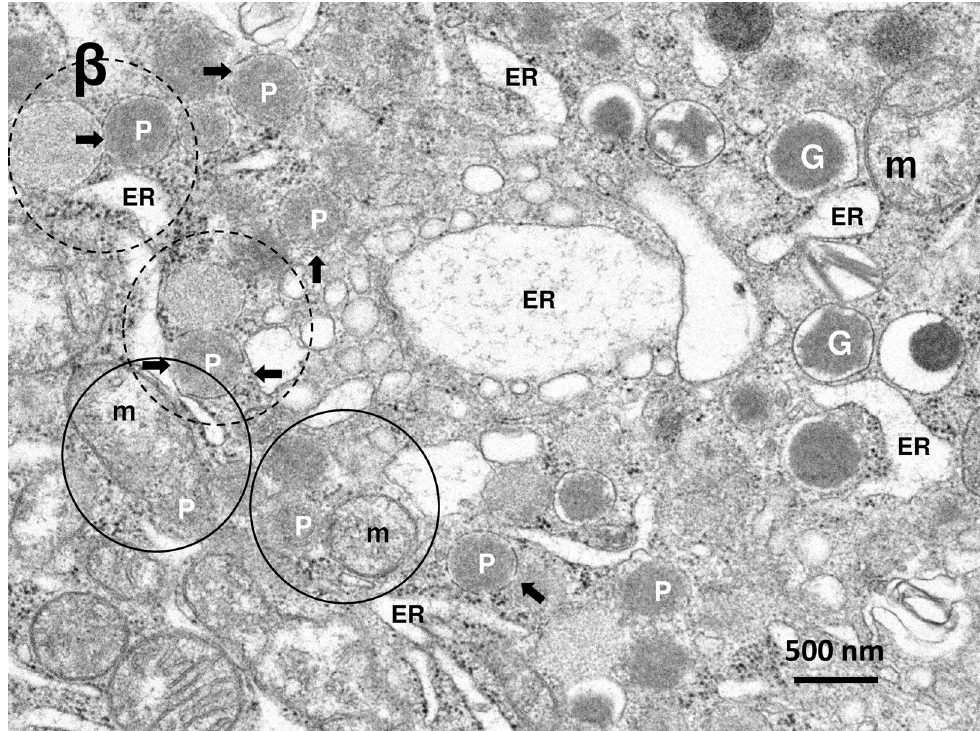
Fig 5. Electron micrograph of the β -cell in the monkey after the hydroxynonenal injections. β -cell shows enlargement of rough ER (ER), as seen in Fig 2. Proliferation of peroxisomes (P) is obvious, and they are intermingled with degenerating mitochondria and insulin granules in the cytoplasm toward the capillary lumen, as seen in Fig 2. Some peroxisomes with membrane disruptions (arrows) are fusing with degenerating mitochondria (m, circles) or autolysosomes presumably containing mitochondrial debris (dot circles). G: insulin